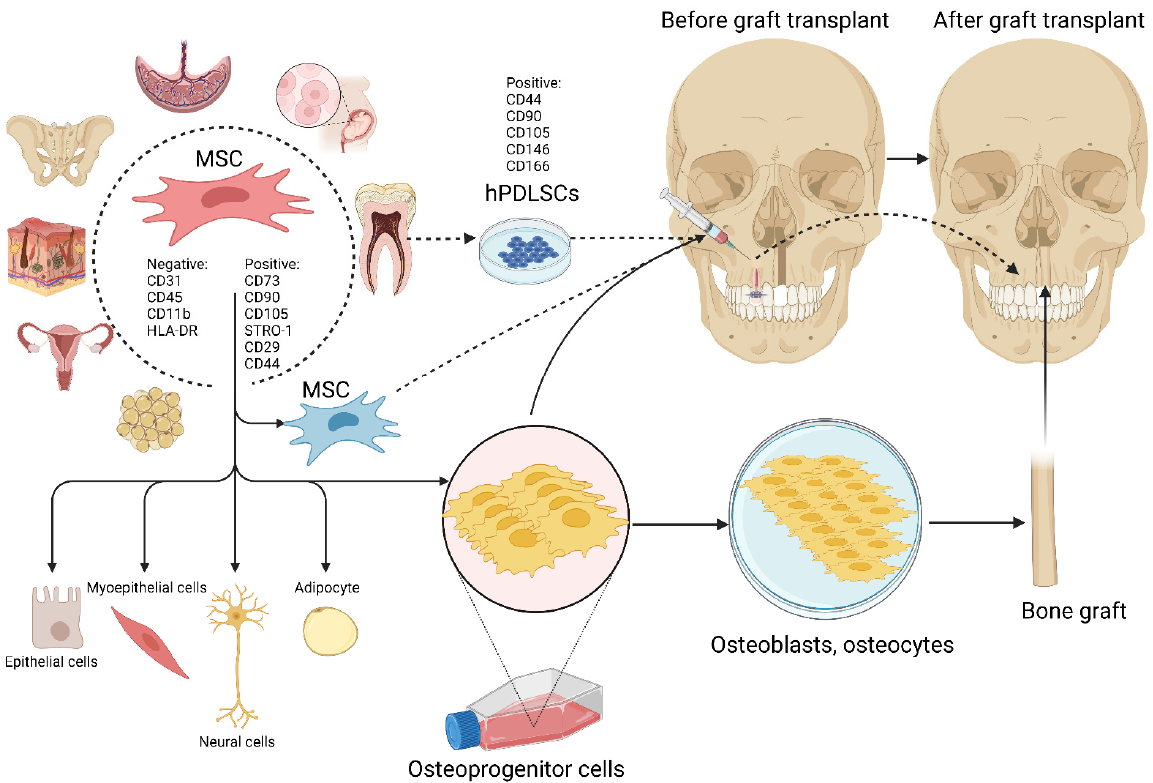
Figure 2. The potential application of SCs in regenerative therapies applicable and designed for orthognatic surgery, including cleft palate. MSC: mesenchymal stem cells, CD: cluster of differentiation, HLA-DR: human leukocyte antigen receptor, STRO-1: mesenchymal precursor cell marker antibody, hPDLSCS: human periodontal ligament stem cells.